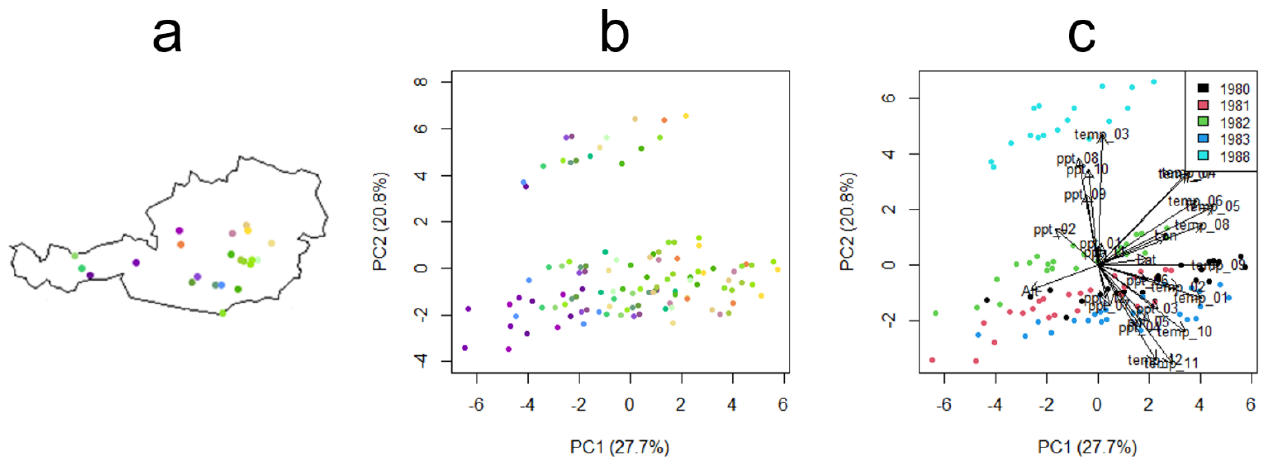
Figure 1. ( a ) Map of trial locations across Austria, labeled based on a combination of altitude, longitude, and latitude. ( b ) Plot of the first and second principal components (PCs) from principal component analysis (PCA) of trial environments (location-year) based on geospatial and climatic data, with trial environments labeled based on a combination of altitude, longitude, and latitude. ( c ) Plot of the first and second PCs from PCA of trial environments based on geospatial and climatic data, with trial environments labeled by year, and PCA eigenvectors for the geospatial and weather predictors plotted as arrows.